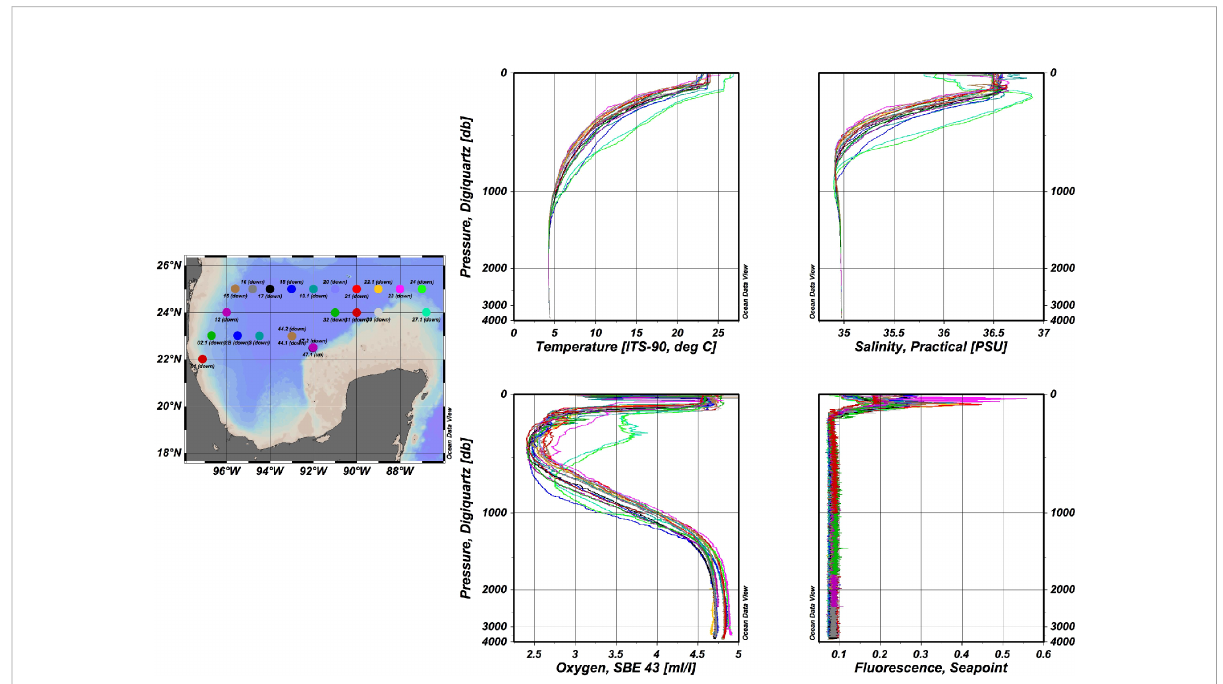
FIGURE 1 CTD data of temperature in °C, salinity in PSU, dissolved oxygen in mL/L and fl uorescence, registered at sampling localities from the northern region of the SGoMex. Color dots correspond to color